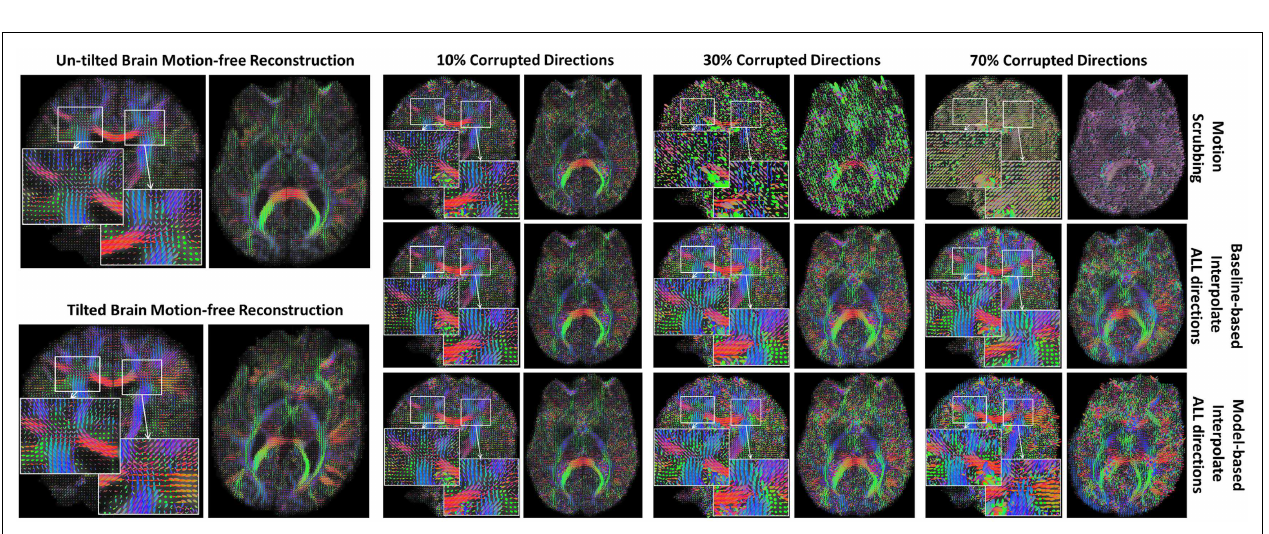
directions . Correction choices shown include outlier-based (i.e., motion scrubbing) and registration-based (using baseline and model-based reference